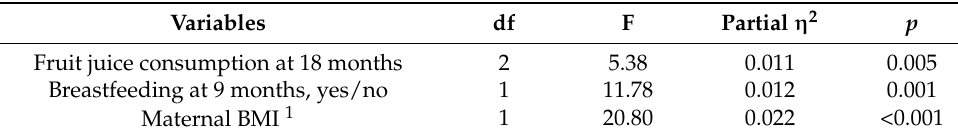
Table 3. Multivariate model for variables associated with body-mass index z -score (BMIz) at 18 months of age. Variables df Partial η